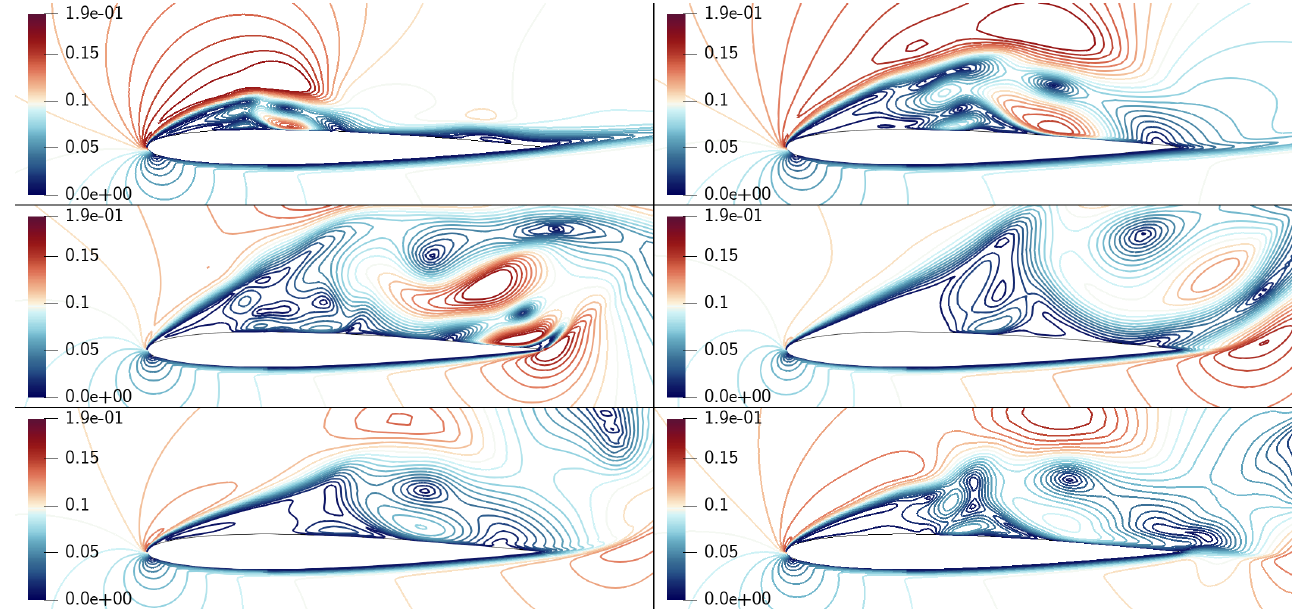
Figure 1. Contours of the Mach number for the impulsive start over the NACA0009 airfoil at different instants of time. Left to right, top to bottom: t = 5.0 × 10 − 3 , 1.0 × 10 − 2 , 1.5 × 10 − 2 , 2.0 × 10 − 2 , 2.5 × 10 − 2 , 3.0 × 10 − 2